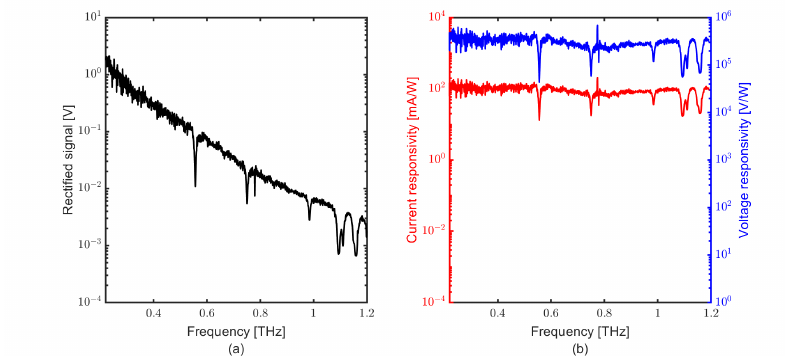
Figure 4. ( a ) Rectified voltage of the SD THz detector with the table-top source, ( b ) current respon- sivity of the SD on left y-axis (red colour) and voltage responsivity on right y-axis with respect to frequency (blue colour), here including the trans-impedance gain of 3.3 × 10 6